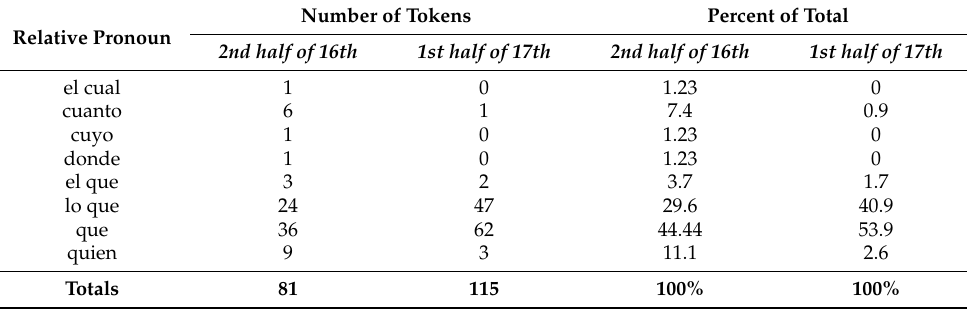
Table 3. Relative pronouns in Corpus 1 by time period.